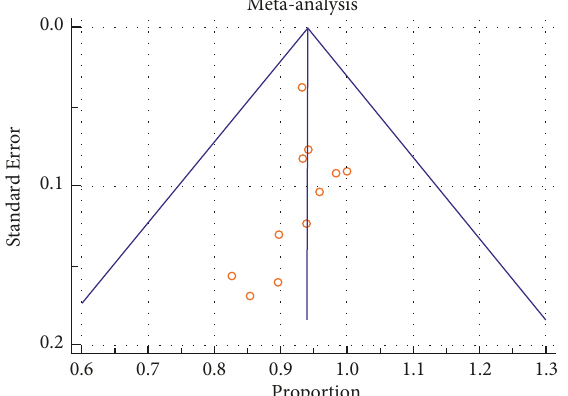
Figure 6: Forrest plot for PP at 1 year in CFE group.